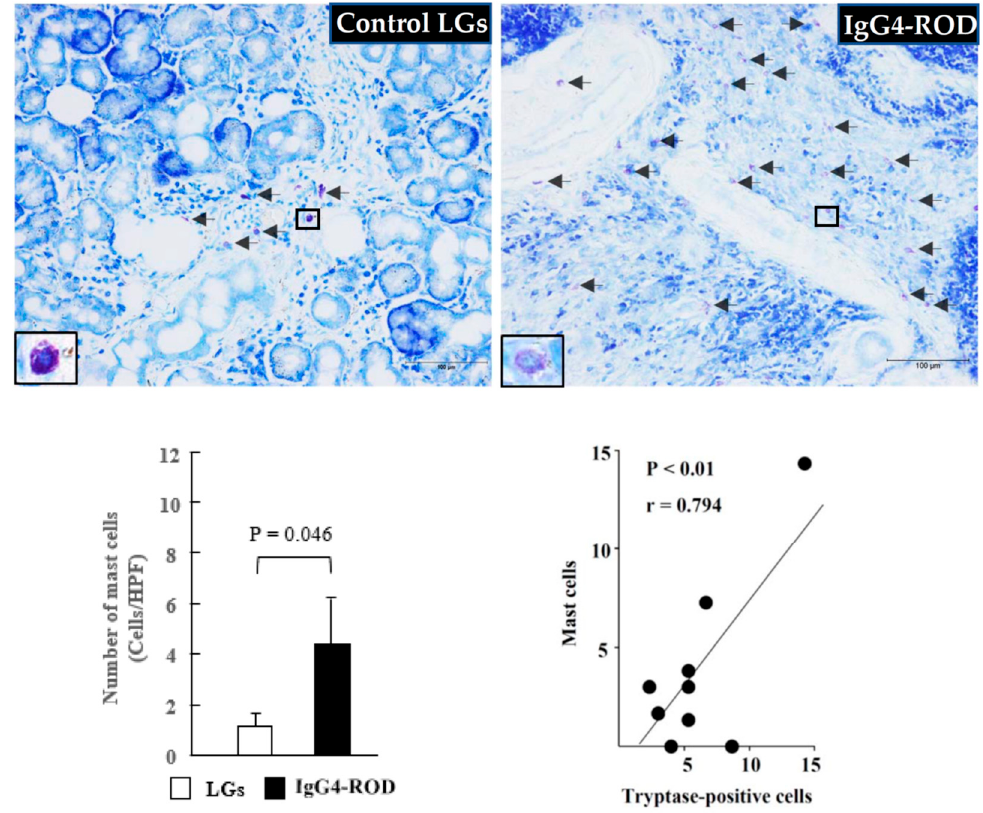
Figure 3. Representative images of toluidine blue staining and MCs population of the LGs obtained from the patients with IgG4-ROD and from the control patients diagnosed with severe canalicular obstruction yet with no IgG4-ROD. Black arrows indicate MCs. Bar graph shows the quantitation of the MCs numbers between the two groups. Line graph shows the linear regression analysis between the numbers of MCs and tryptase-positive cells in all data of the examined LGs.